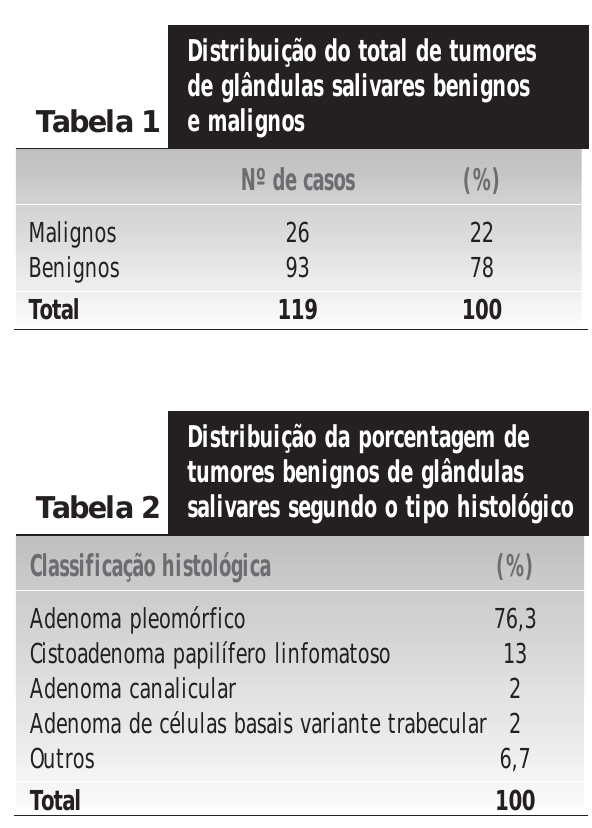
a Tabela 4 . Na Figura , as faixas etárias que apresenta- ram o maior número de casos foram as compreendidas entre 31-40 anos, 21-30 e 51-60. A Tabela 5 apresenta a distribuição topográfica, sendo a parótida o sítio mais freqüente, com 84 casos (70,6%), seguida por 23 casos da glândula submandibular (19,3%), 11 de glândulas sa- livares menores (9,24%) e um caso de glândula sublingual bos os